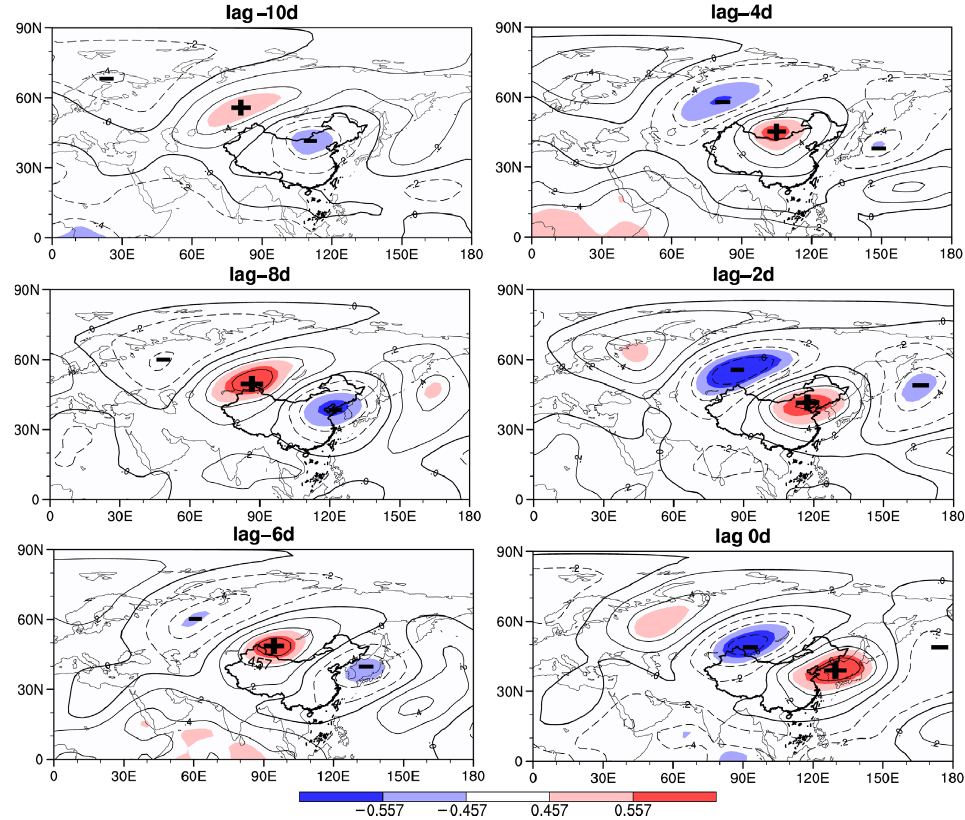
Figure 9. Distribution of lead–lag correlation coefficients between the 10–20 d regional average minimum temperature series in northern China and the 500 hPa geopotential height fields. Shaded areas enclose regions of larger than 0.1 significance.